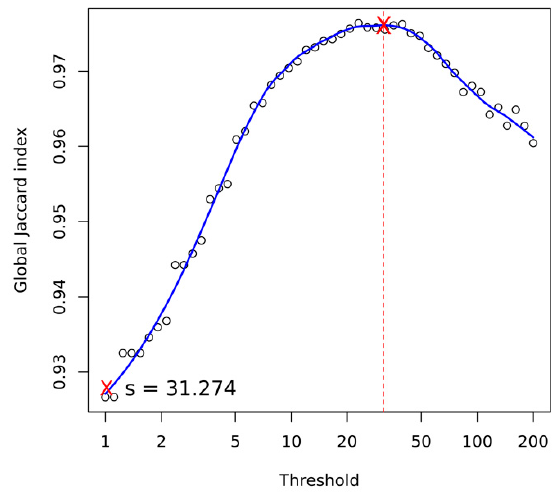
Figure A2. Results of the low expression filtering step performed with HTSFilter. The algorithm calculated a Global Jaccard index (blue line) of similarity (on the Y -axis) between the samples in function of different minimum normalized read counts (on the X -axis, red crosses indicate the minimum and the maximum values). The graphic shows that for s = 31.274 the replicates have the highest similarity; thus, this value was used as a threshold.